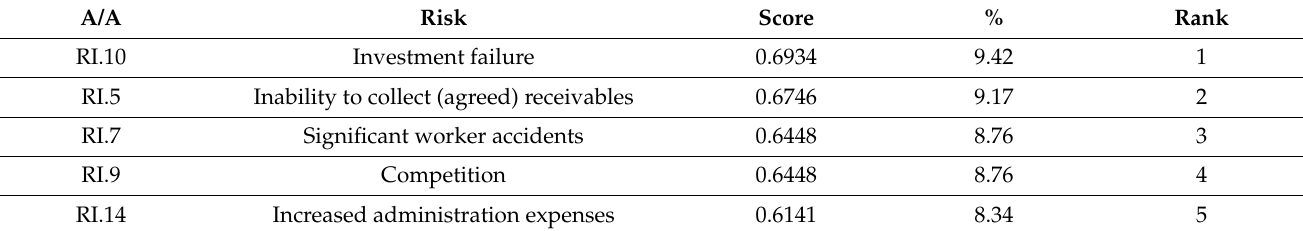
Table 7. Most important risks according to the TOPSIS entropy method.